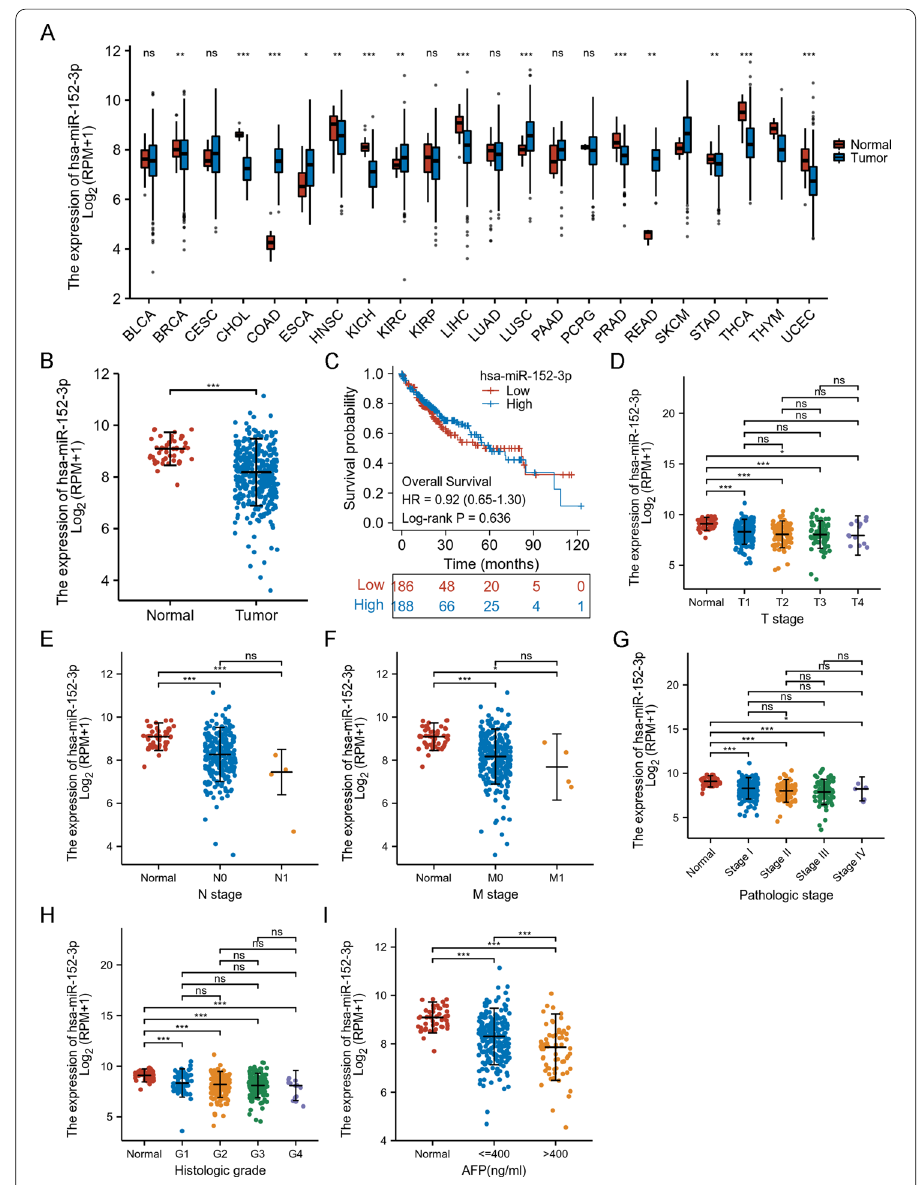
Fig. 9 Clinical significance of miR-152-3p in HCC. miR-152-3p expression in pan-cancer analysis of TCGA database ( A ). miR-152-3p expression in TCGA database ( B ). The association between miR-152-3p and OS ( C ), T ( D ), N ( E ), M ( F ) and pathologic stage ( G ), and histologic grade ( H ). miR-152-3p low expression was significantly correlated with high AFP levels in HCC patients ( I ). * p < 0.05; *** p <